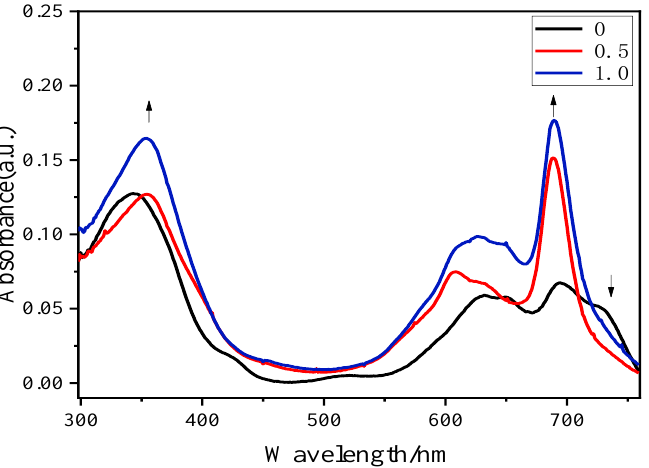
Figure 6. UV–vis titration spectra of Mg-NPc 1 in CH 2 Cl 2 -MeOH (7:3, v / v ) in the presence of different amounts of AgClO 4 (0, 0.5, and 1 equiv).